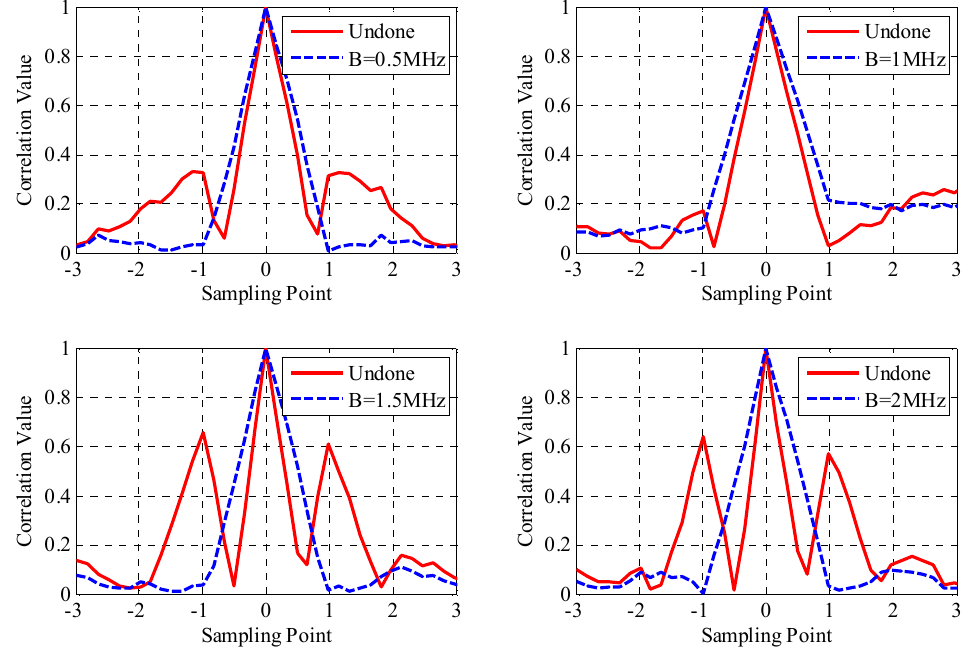
Figure 16. Sidelobes suppression results under different interference bandwidths.